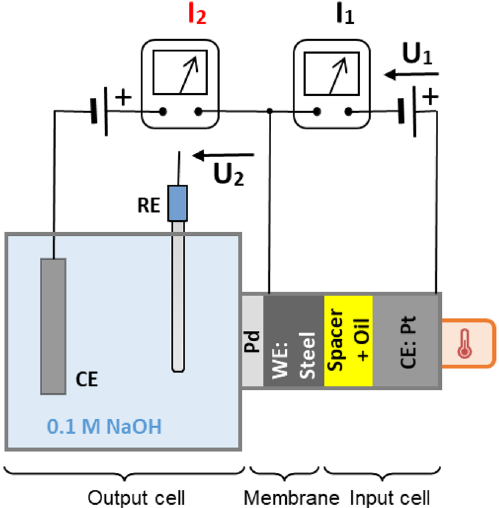
Figure 1. Schematic representation of the modified Devanathan–Stachurski cell. RE reference electrode, CE counter electrode, WE working electrode.